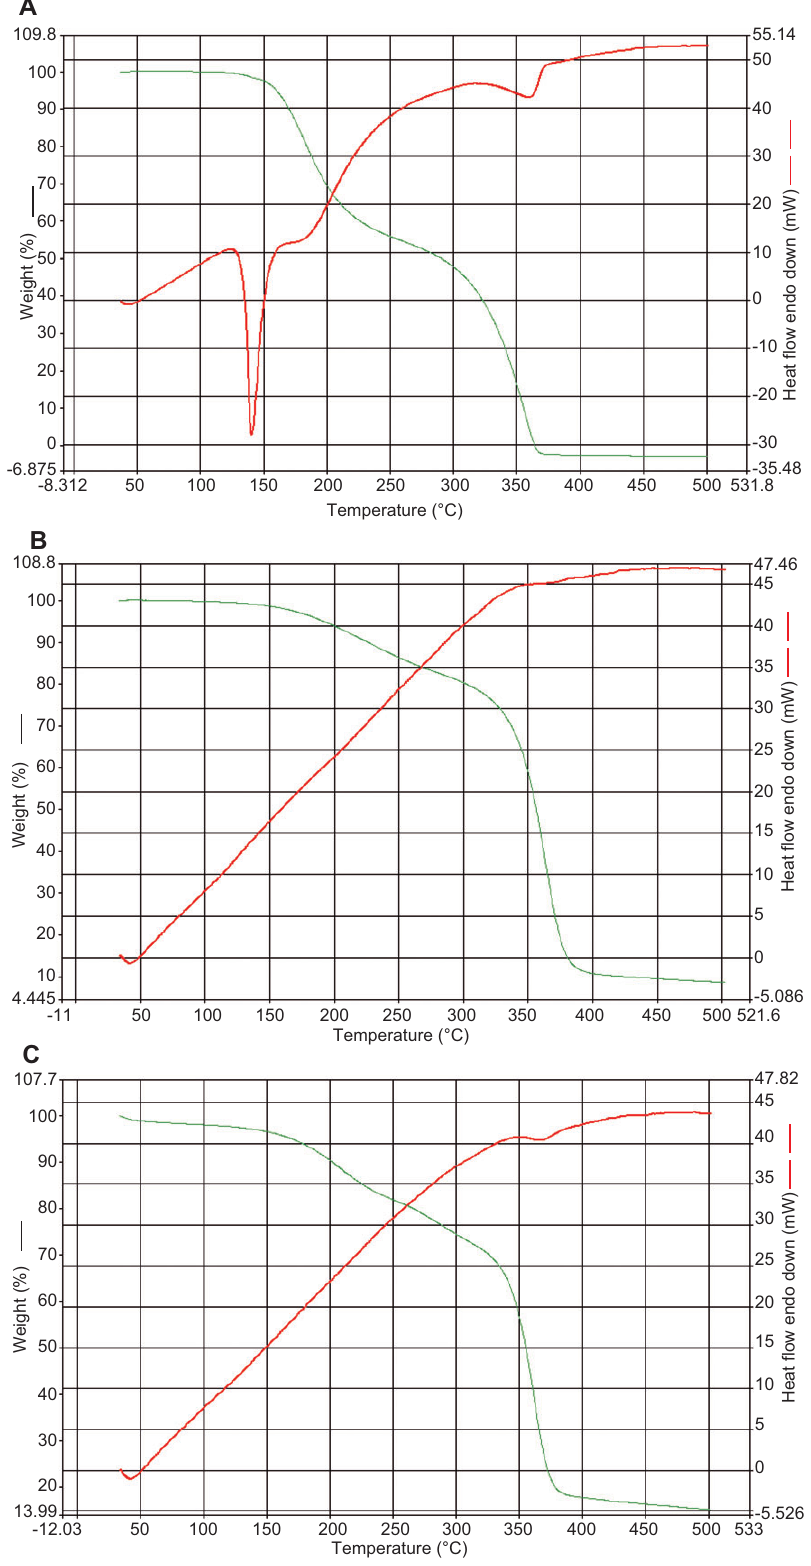
Figure 9 DSC thermograms of (A) pure aspirin, (B) blank ethyl cellulose microparticles and (C) aspirin-loaded ethyl cellulose